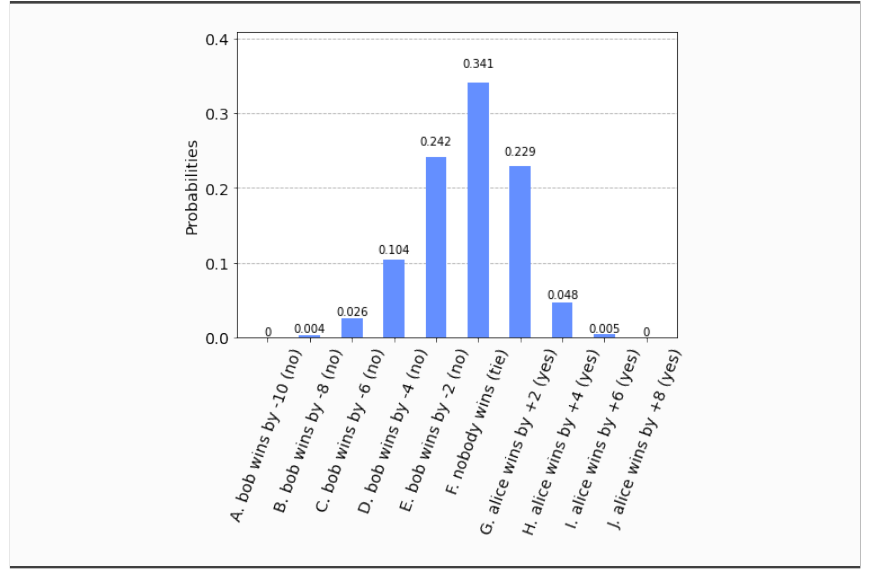
Figure 15. The possible outcomes and their probabilities when r A = 0.70 and r B =